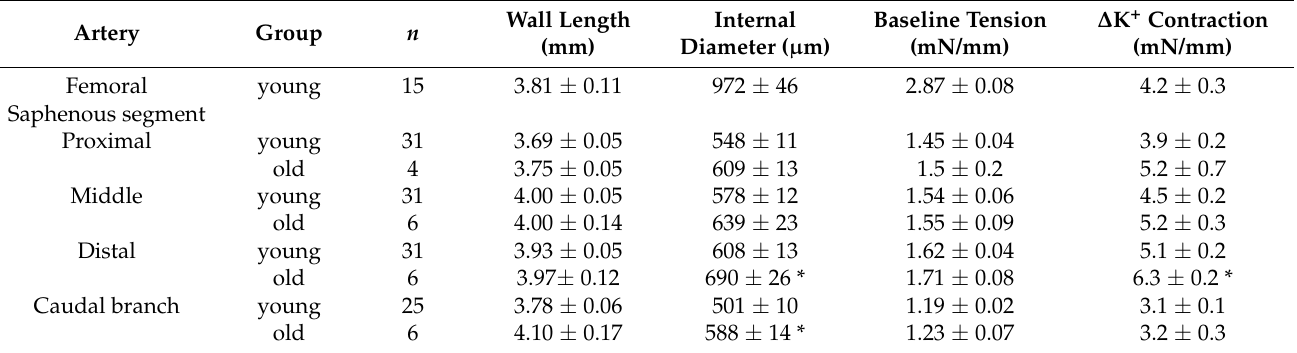
Table 1. Blood vessel internal diameters and resting tension at baseline, and active tension induced by 90 mM extracellular K + in hind limb arteries from young and old Sprague Dawley rats.